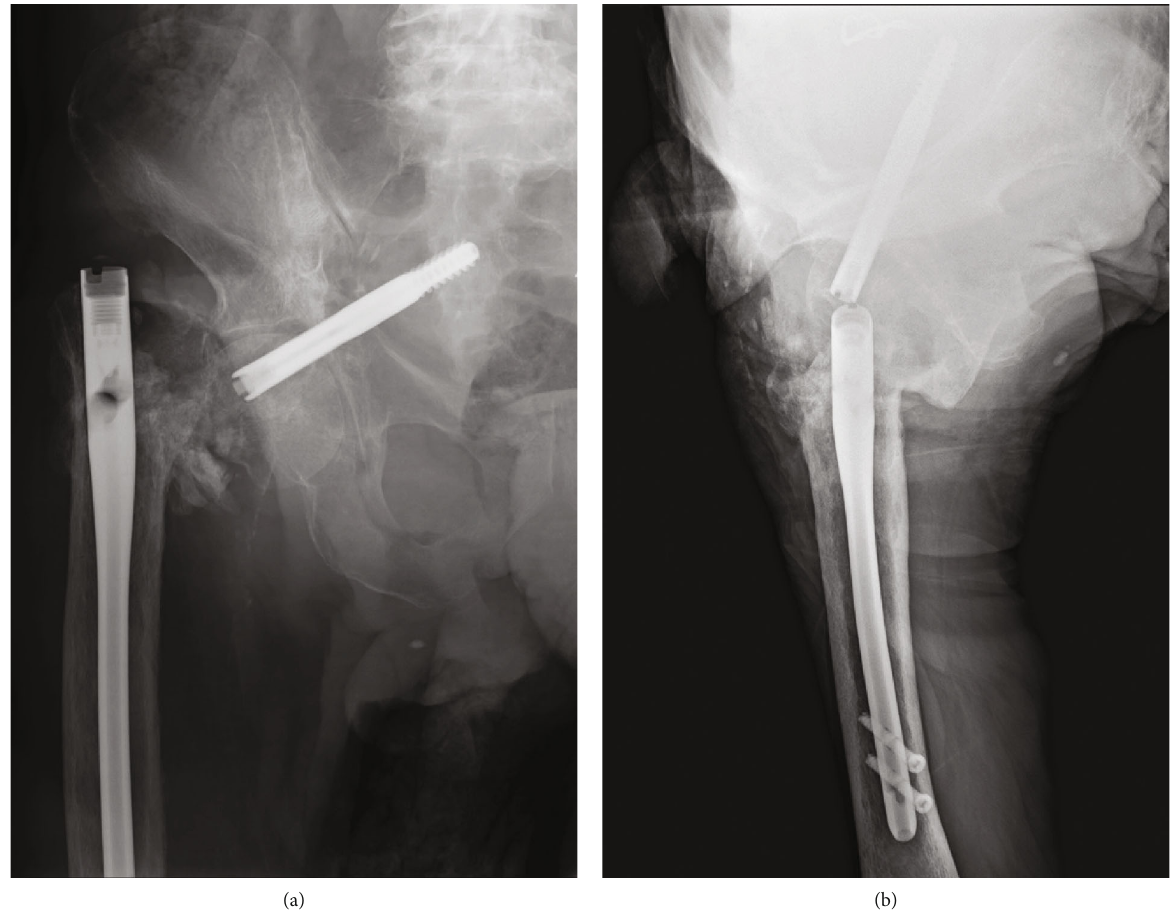
Figure 3: Radiographs showing redisplacement of the fracture and intrapelvic migration of the lag screw through the femoral head and the medial wall of the acetabulum.